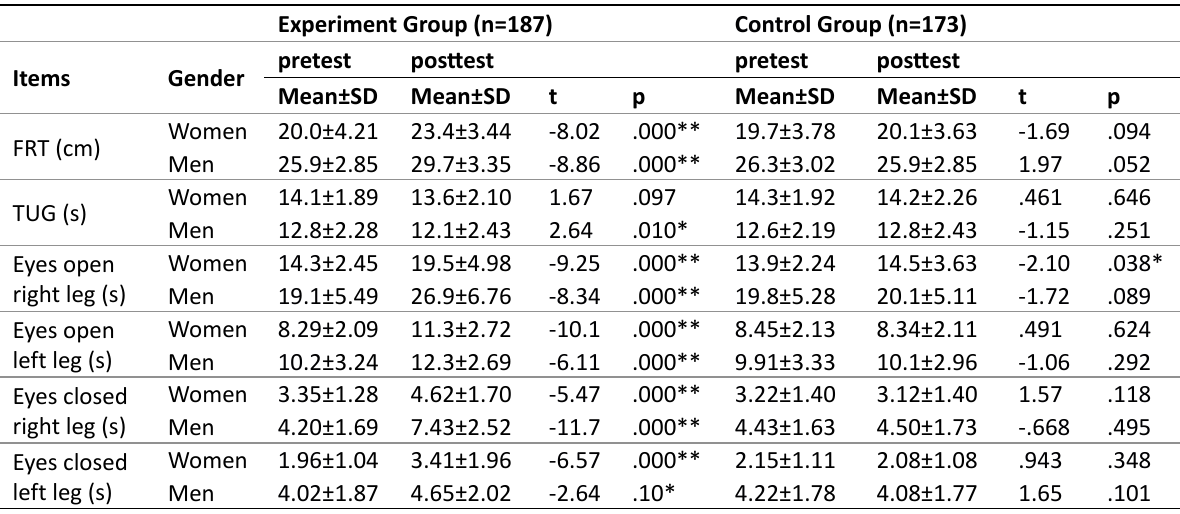
Table 2. Pretest and posttest results of experiment and control groups in FRT, TUG, eyes open right leg, eyes open left leg, eyes closed right leg, eyes closed left leg (Paired Sample t-Test)